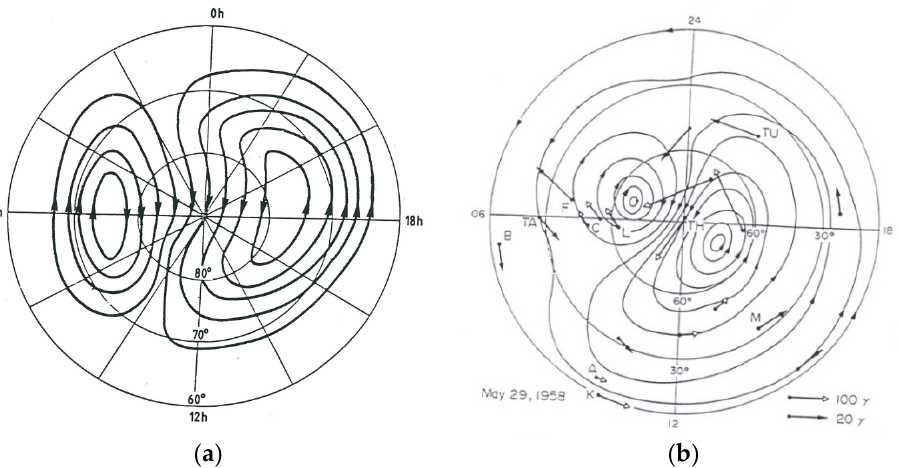
Figure 6. ( a ). The two cells of the equivalent S qP current system, magnetic quiet period [32]. ( b ). The two cells of the equivalent DP 2 current system, disturbed magnetic period [30].